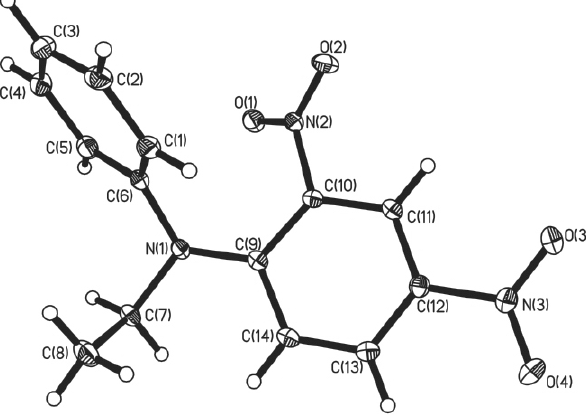
substituted ring. The bond distances of C—C in the two phenyl rings range from 1.373(2) to 1.392(2) Å.The two phenyl rings are not parallel with a dihedral angle of 65.23(4)°. The bond distances between two phenyl rings and N1 are d (C6—N1) =